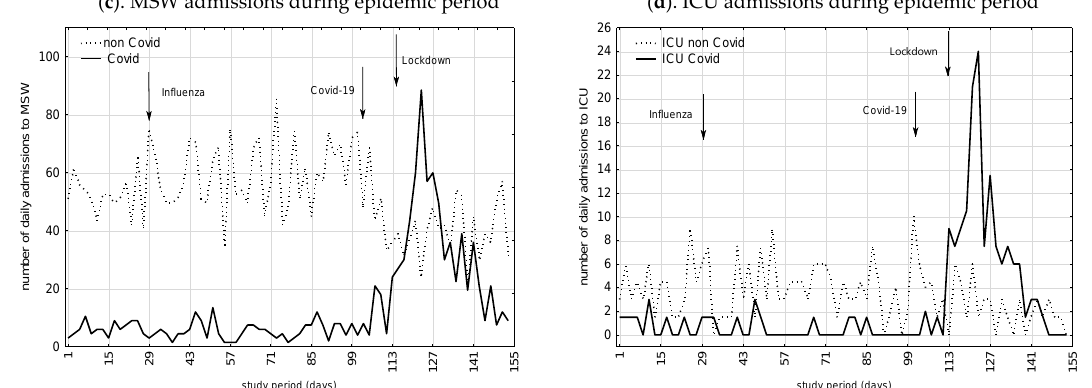
Figure 2. ( a ) ED visits during the entire study period, from 25 November 2018 to 25 November 2019 (pre-epidemic period) and from 26 November 2019 to 26 March 2020 (study period including influenza- and COVID-19-epidemic and lockdown periods); ( b ) ED visits subgroups during Influenza, Covid-19, and lockdown periods (from 26 November 2019 to 26 March 2020); ( c ) MSW admissions during epidemic period